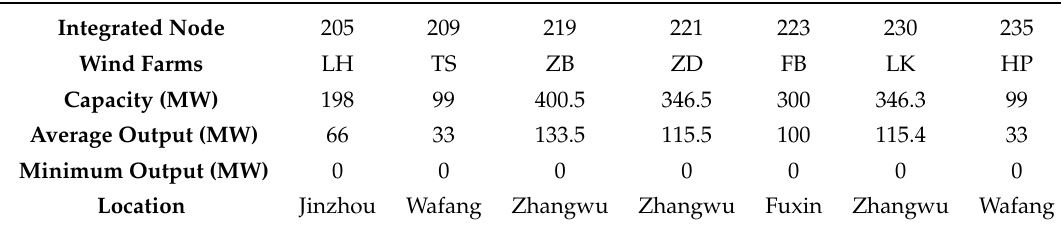
Figure 5. Illustration of the transmission network of Liaoning provincial power grid. Table 8. Information of wind